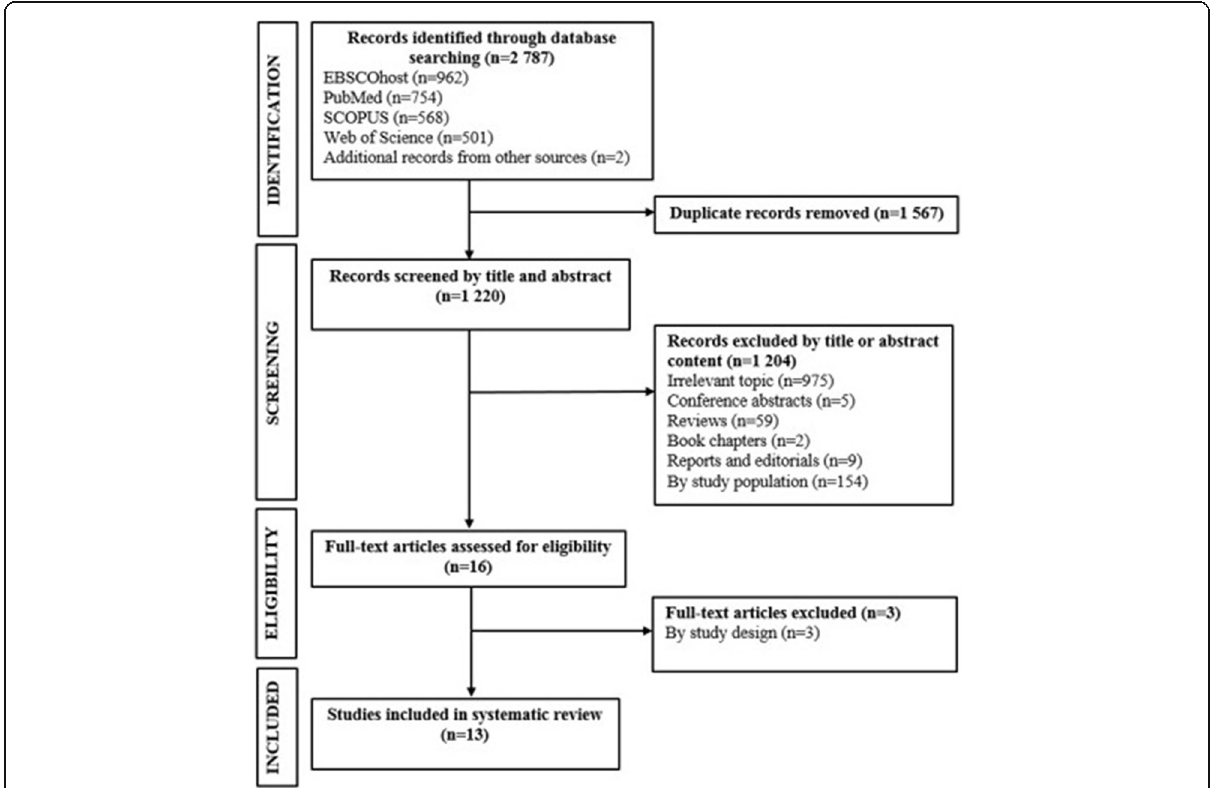
Fig. 1 Selection process for studies included in the systematic